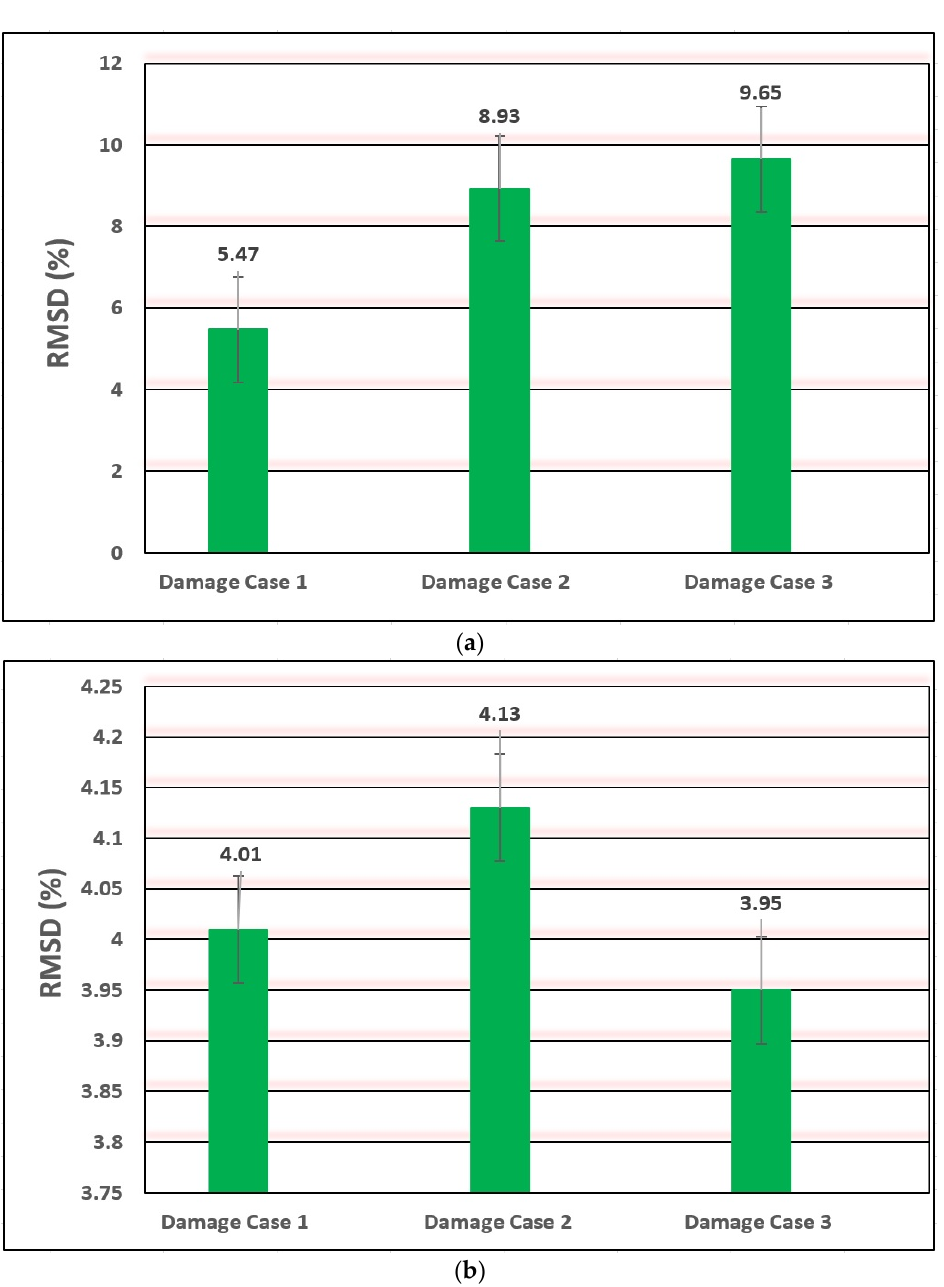
Figure 11. RMSD for damage cases of specimens ( a ) combination of plate and pipe (H09) and ( b ) combination of two steel pipes (T04).